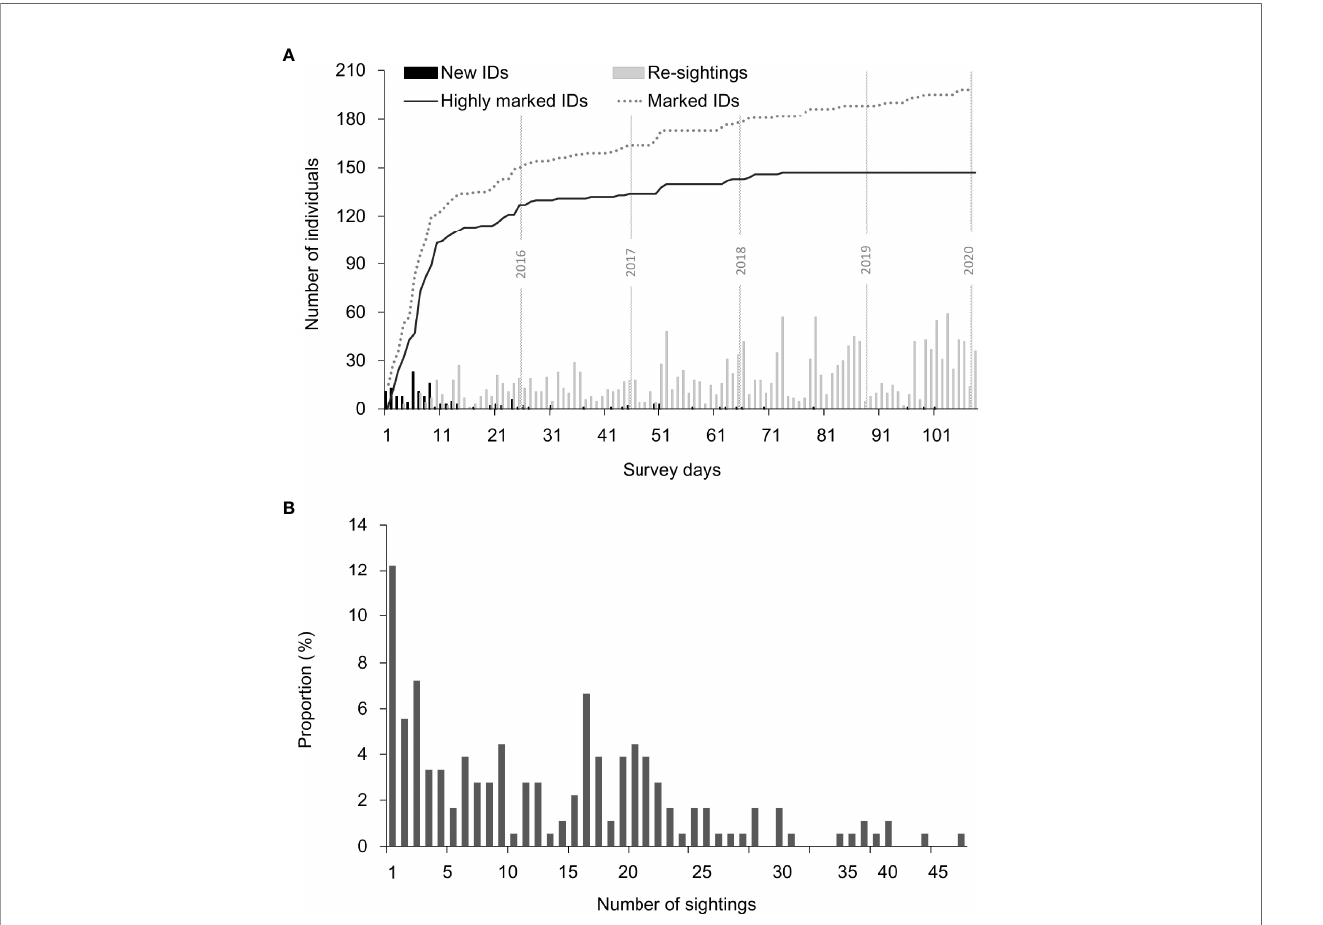
FIGURE 2 | Evaluating the photo-identi fi cation data robustness for the DRE Indo-Paci fi c humpback dolphins collected during 2015 and 2019 in the measurement of (A) cumulative discovery curves, in which the curves were presented for both all individuals (dotted line) and highly marked individuals (distinctiveness/D ≥ 3, dark line), and the number of individuals sighted for the fi rst time (New ID) or re-sightings during each survey day shown as histogram in the bottom; the horizontal lines in gray indicated the 5 sampling years of the present study. (B) The distribution of sighting frequencies for highly marked